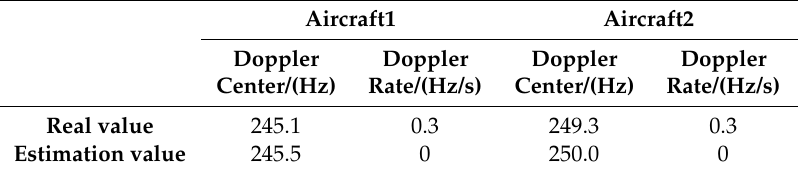
Table 3. Parameter estimation result.